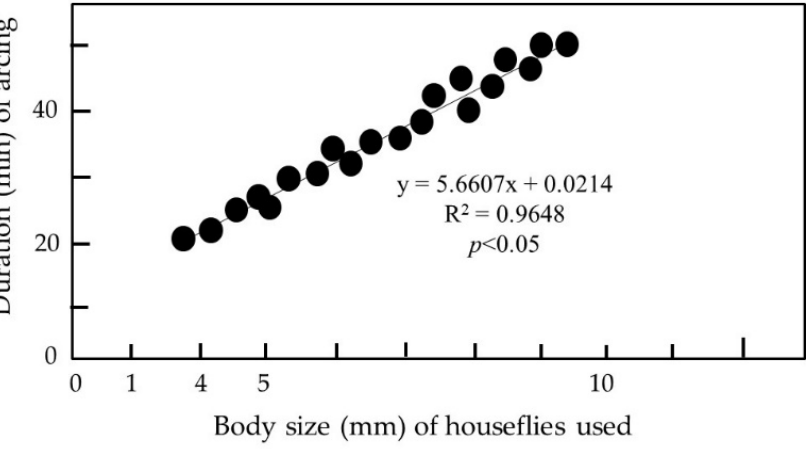
Figure 7. Relationship between the body size of houseflies and the length of time required for the arc-discharge exposure of houseflies to stop autonomously.